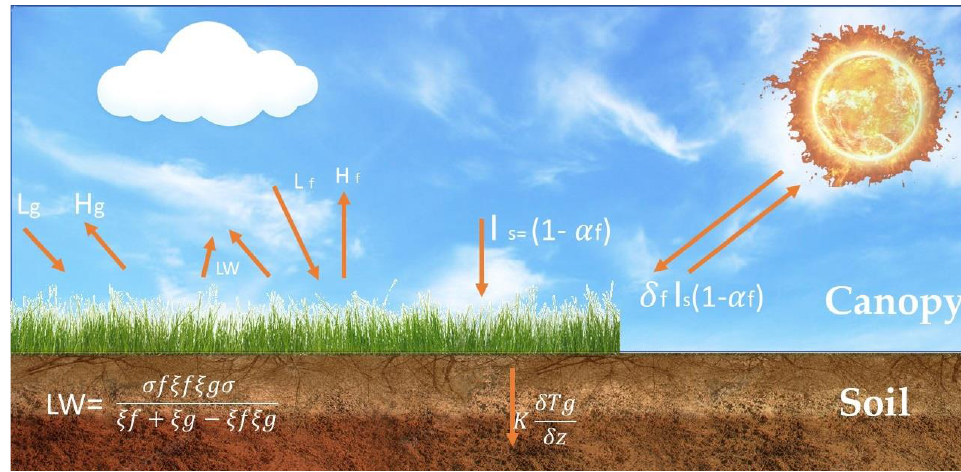
Figure 5. Main heat flow on a green roof.